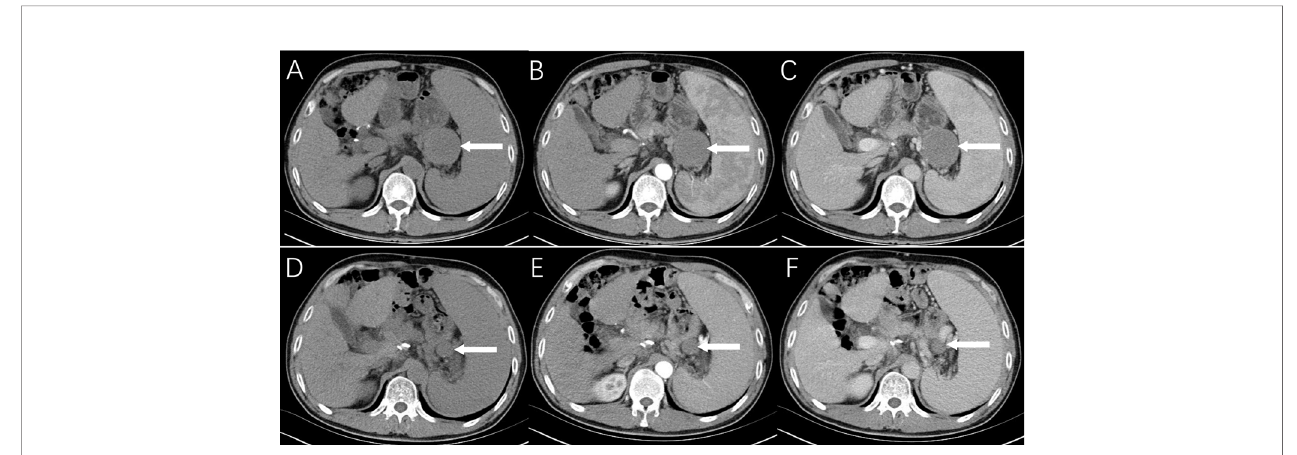
FIGURE 1 | Radiological fi ndings of reactive nodular fi brous pseudotumor. Multiphasic abdominal CT shows a solid mass measuring 5.0 cm × 5.2 cm in the operative area of gastric cancer with a relatively clear boundary, isodensity, and no necrosis (A) , mild enhancement in the arterial phase (B) , and increased contrast enhancement on portal venous phase (C) . On abdominal CT images (D – F) at 8 months ago, only a nodule with a maximum diameter of 1.0 cm was